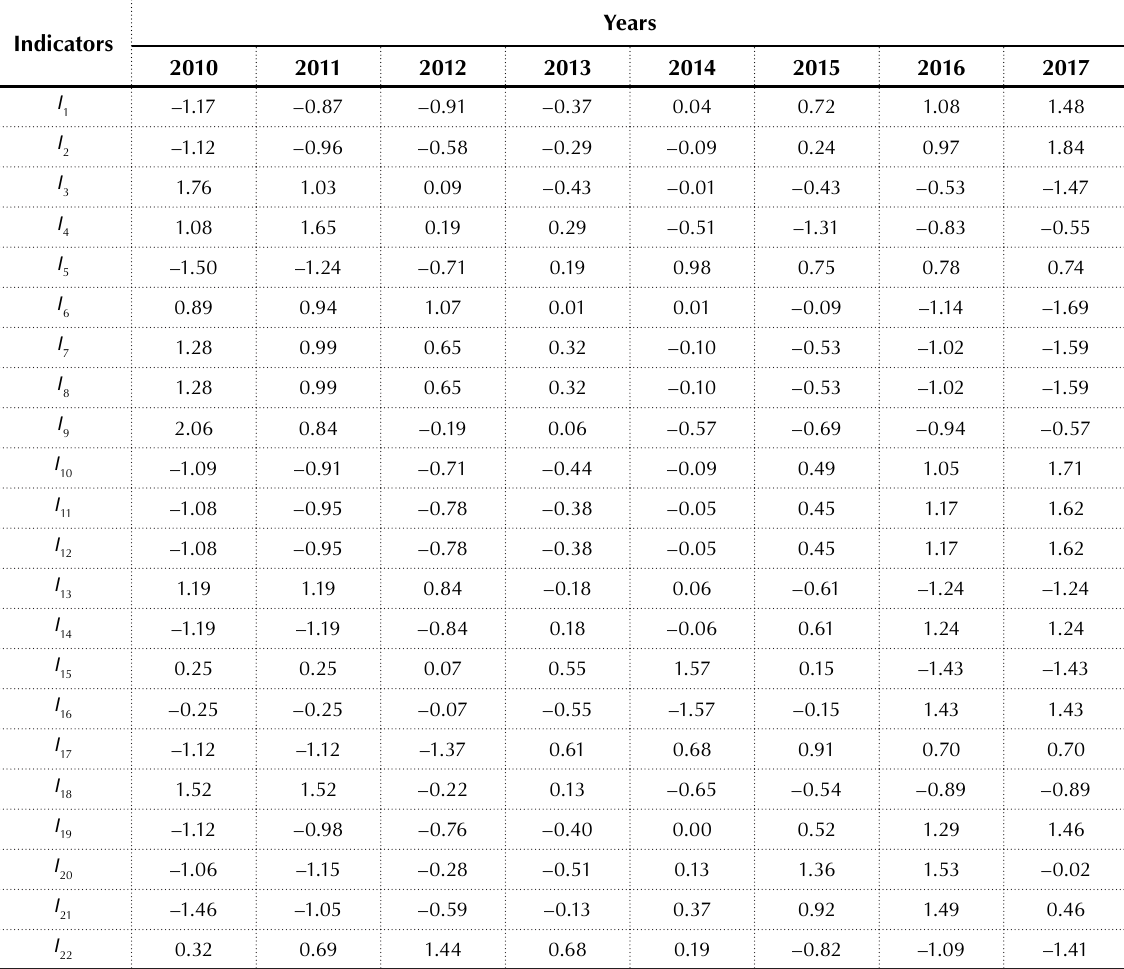
Table 3. An array of source data for assessment of the socio-economic potential of health insurance by a discriminative model/specified values